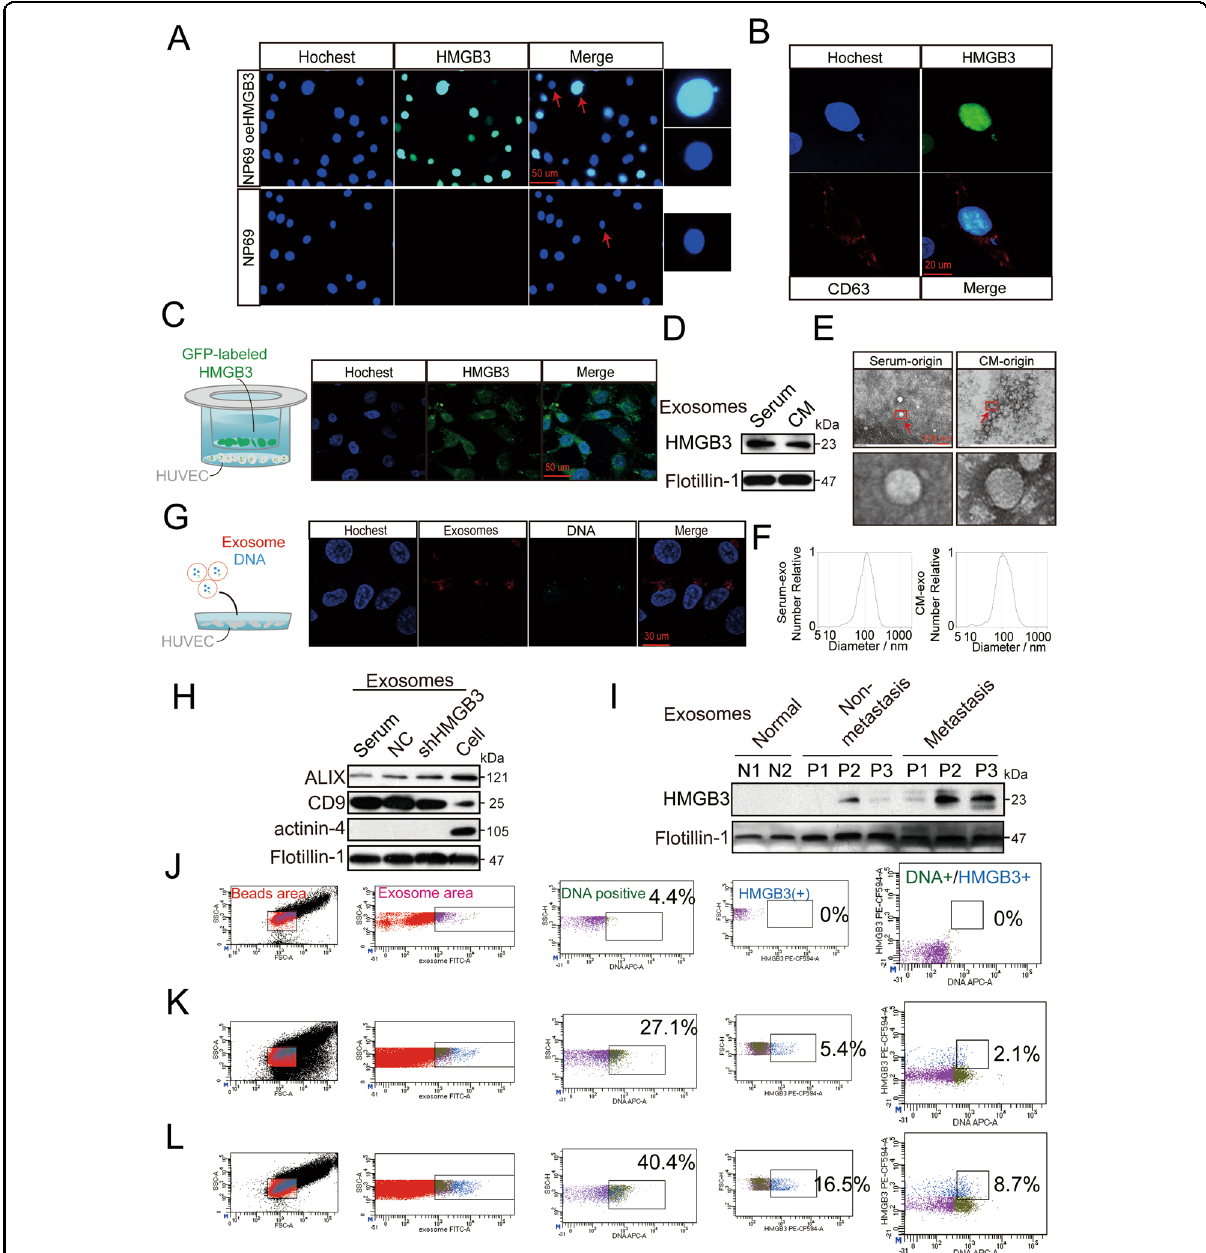
Fig. 6 Nuclear exosomes HMGB3 derived from the micronucleus can be transferred from CNE2 to HUVECs and is associated with NPC metastasis. A Immuno fl uorescence (IF) images of NP69 with or without HMGB3 overexpression. The right images show a magni fi ed nucleus and MN. The scale bar represents 50 µm. B IF images of NP69 oeHMGB3 were stained by HMGB3 (green), CD63 (red), and nucleus (blue). The scale bar represents 20 µm. C CNE2 cells transfected with fl uorescent GFP-labelled HMGB3 overexpresses lentivirus were cocultured with HUVECs in a transwell Chamber. The scale bar represents 50 μ m. D Western blotting analysis of the expression of HMGB3 in exosomes from NPC serum and CNE2-CM (cell medium). E Transmission electron microscopy of exosomes derived from NPC serum and CNE2-CM. The scale bar represents 200 nm. The red boxes indicate regions of pictures shown in the bottom two pictures. F Nanoparticle tracking analysis showed the size and distribution of exosomes isolated from NPC serum and CNE2-CM. G HUVECs uptake of exosomes released by NPC with a confocal microscope. blue: Hoechst staining; red: PKH26-labelled exosomes; light blue: DRAQ5 dye-labelled DNA. H Western blotting analysis of Alix, CD9, actinin-4 and fl otillin-1 in NPC exosomes and CNE2 cells. I Detection of HMGB3 in serum exosomes of NPC patients and normal persons by Western blot. J – L Flow cytometry analysis showed the percentage of gDNA and HMGB3 expression in exosomes of NPC patients and normal persons. J: normal persons; K: NPC patients without metastasis; L: NPC patients with metastasis.